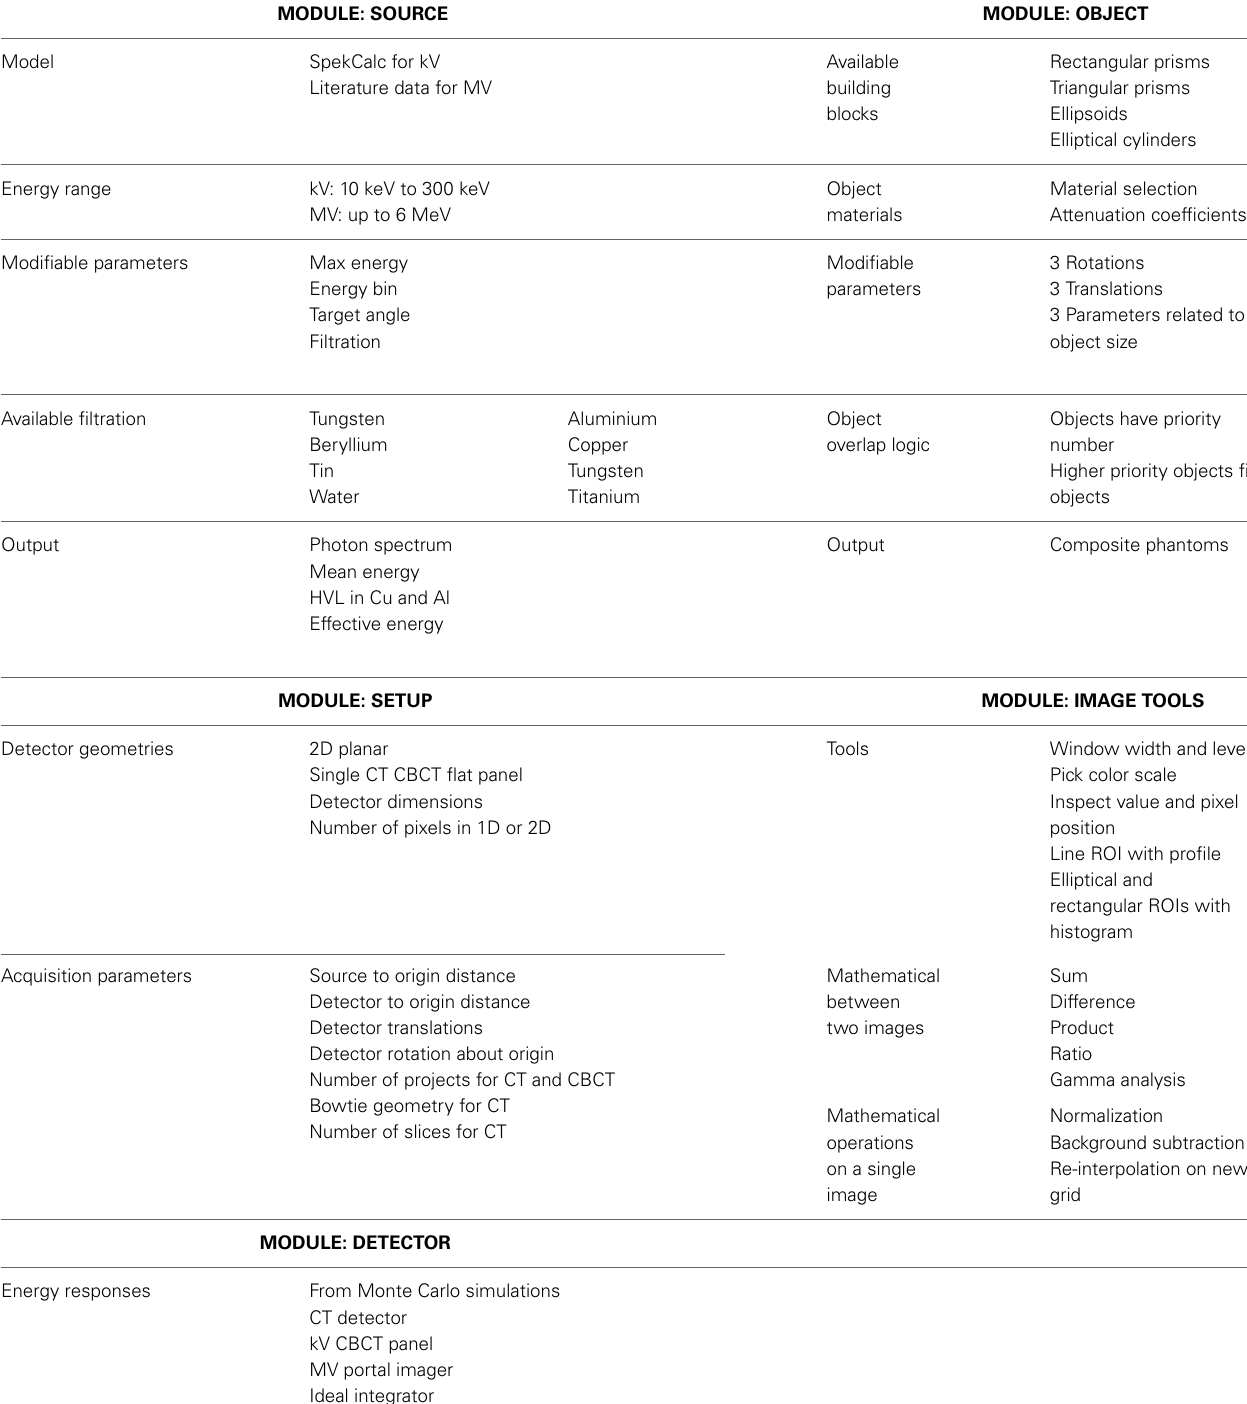
Table 1 | The main imaging parameters and capabilities of ImaSim